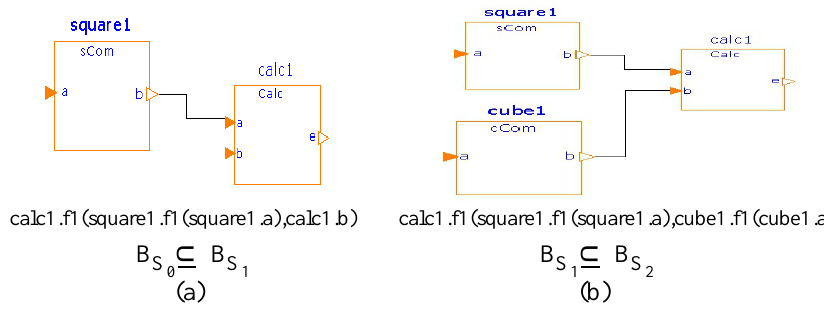
Figure 14. A basic-pnf System in Modelica: ( a ) First system and ( b ) Second system.